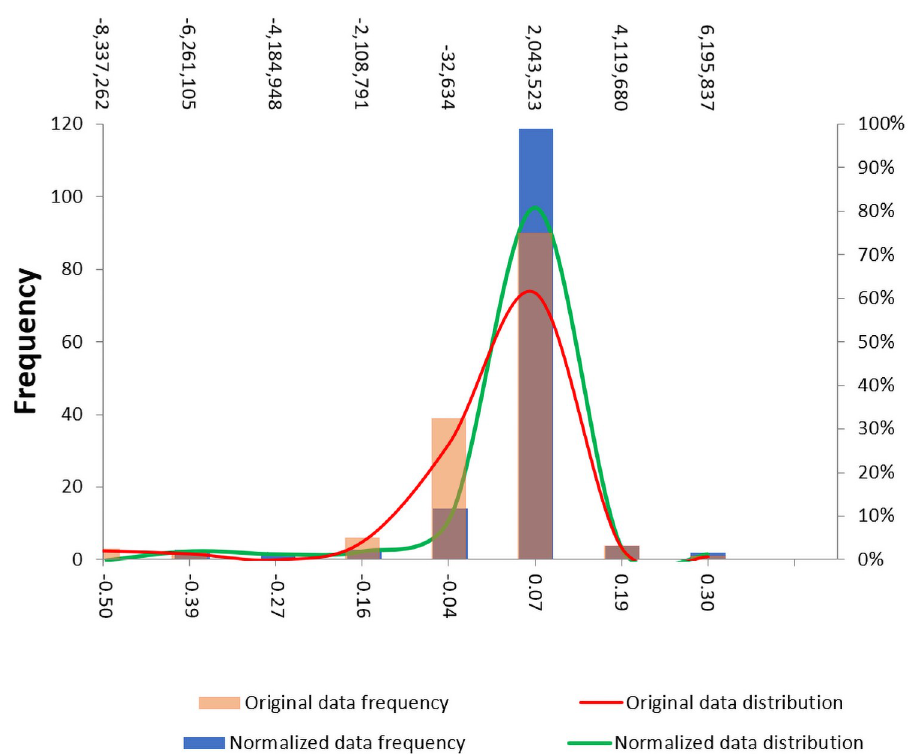
Fig 13. Distribution of the general competitiveness indexes before and after the normalization.